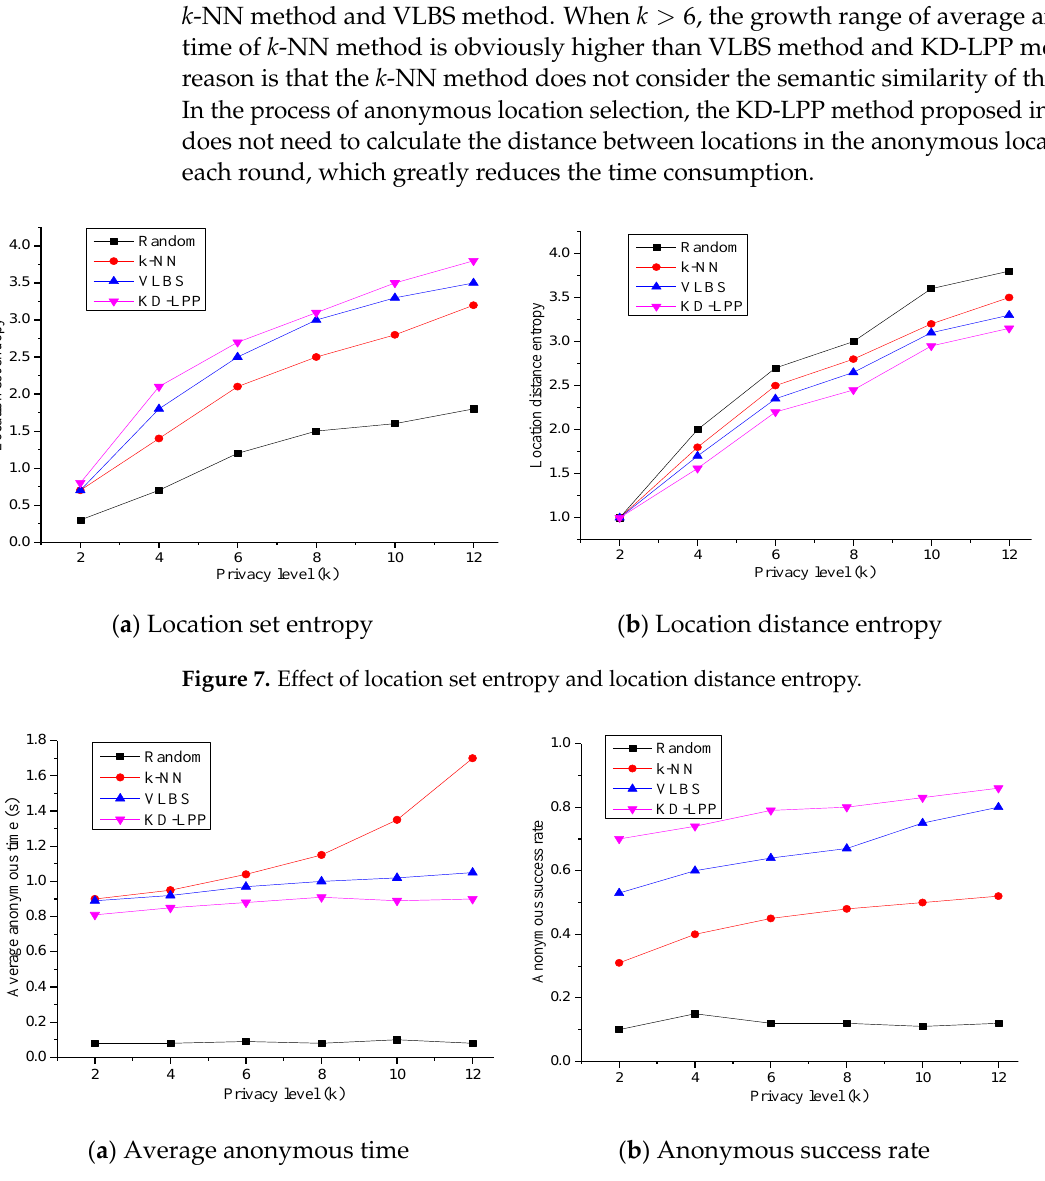
Figure 8. Effect of average anonymous time and anonymous success rate.